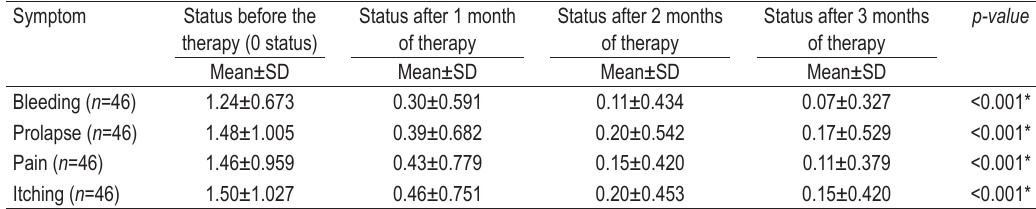
TABLE 1. Comparison of the mean scores for each analyzed symptom (bleeding, prolapse, pain, and itching) among the study participants during the follow‑up period Symptom Status before the